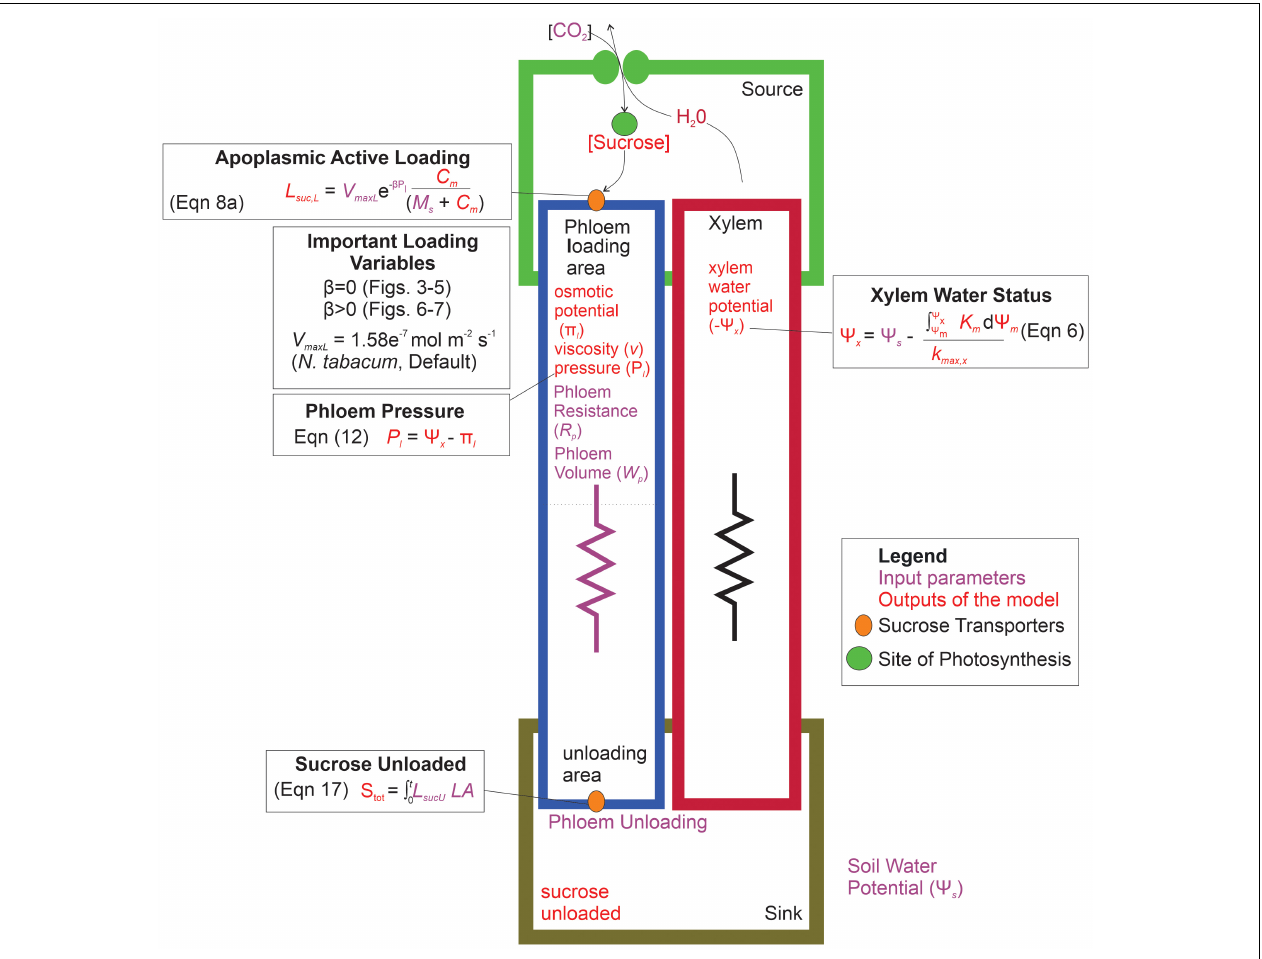
FIGURE 2 | Parameterization and conceptual schematic of the water and sugar transport model. The model inputs are shown in purple, while the outputs of the model are in red. The model first produced a xylem water potential based on the input soil water potential. Sucrose concentrations are built in the leaf compartment (source), and actively loaded into the phloem through protein transporters. Loading variables that were altered in the different simulations are shown, which impact the resulting phloem specific outputs such as: phloem osmotic potential, viscosity, pressure, and the eventual sucrose exported to the sink area. Symbols: L sucL = loading rate per unit leaf area, V maxL = maximum rate of sucrose uptake, β = shape parameter for loading downregulation, Pl = phloem pressure in loading area, C = concentration of sucrose in source area, M S = Michaelis-Menten constant for sucrose affinity, S tot = total sucrose exported over the entire simulation, L sucU = total unloading rate, LA = leaf area, (cid:57) m = water potential of source area, k m = hydraulic conductivity of mesophyll, k max , x = maximum hydraulic conductivity of